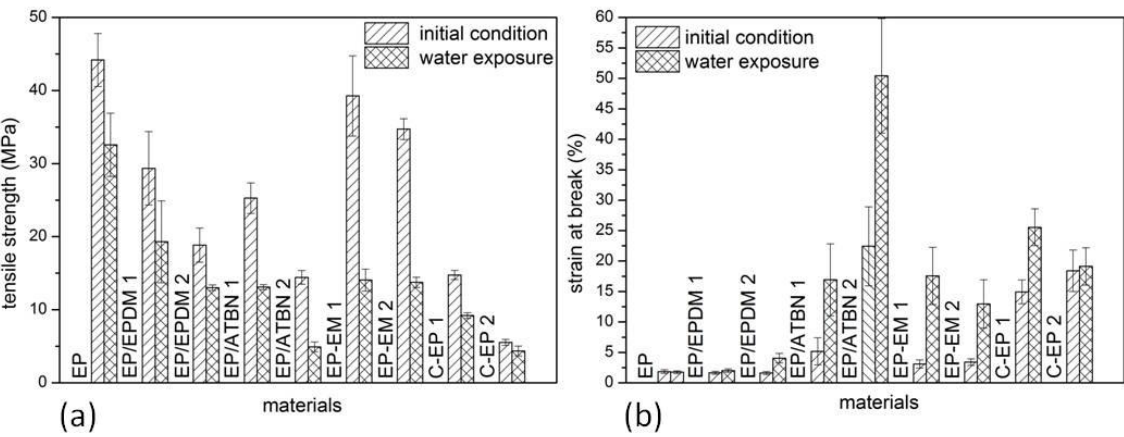
Figure 2. Results of the tensile test. ( a ) Tensile strength of the initial condition (fully cured) and of samples after water exposure for 28 days at 40 °C; ( b ) Strain at break of the initial condition (fully cured) and of samples after water exposure for 28 days at 40